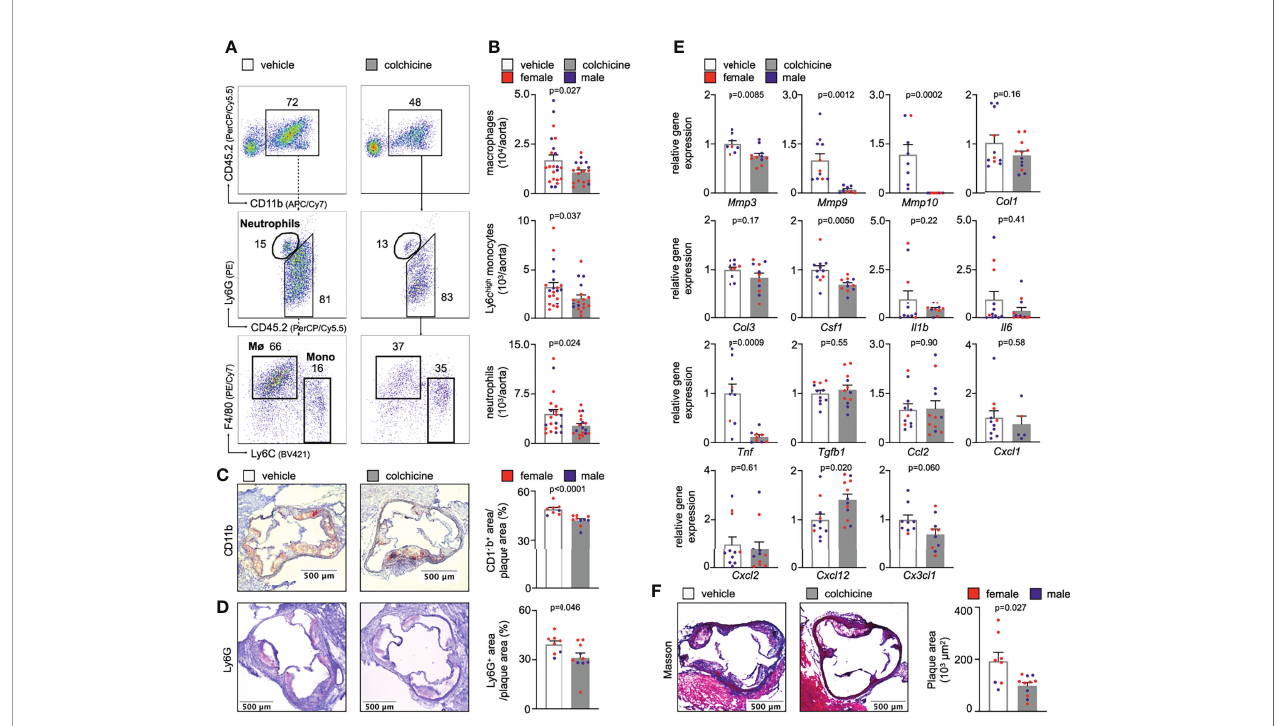
FIGURE 1 | Colchicine treatment reduces plaque in fl ammation. (A) Flow cytometric gating and (B) quanti fi cation of myeloid cells in atherosclerotic aortas in vehicle- vs. colchicine-treated Apoe -/- mice ( n =18-21 per group, 62-67% female, Welch ’ s t -test for macrophages (Mø), Mann-Whitney U -test for monocytes (Mono) and neutrophils as appropriate). Numbers next to gates indicate population frequencies (%). Representative immunohistochemical staining for (C) myeloid cells (CD11b) and (D) neutrophils (Ly6G) of sectioned aortic roots from vehicle- vs. colchicine-treated Apoe -/- mice ( n =8-10 per group, 60-75% female, Mann-Whitney U -test for CD11b, Student ’ s t -test